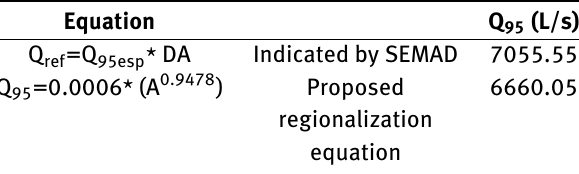
Table 4: Estimated Q 95